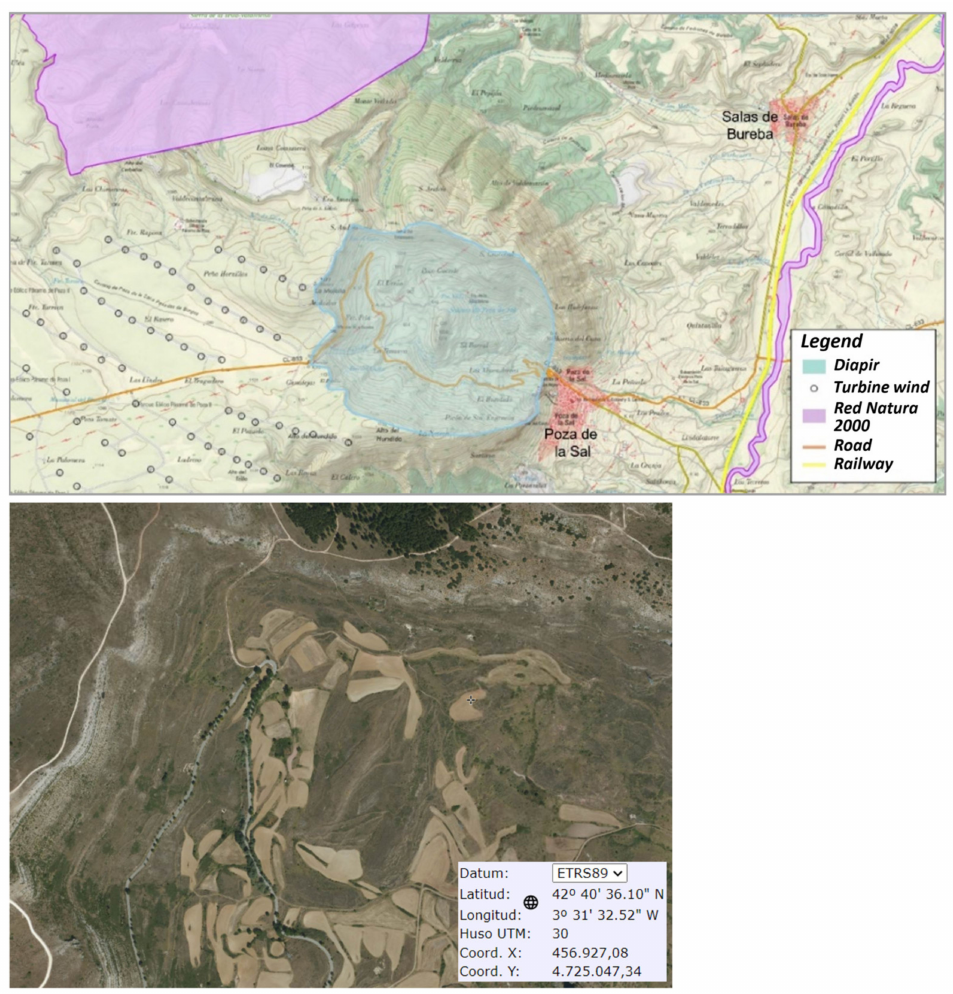
Figure 3. Location and environment of the diapir of Poza de la